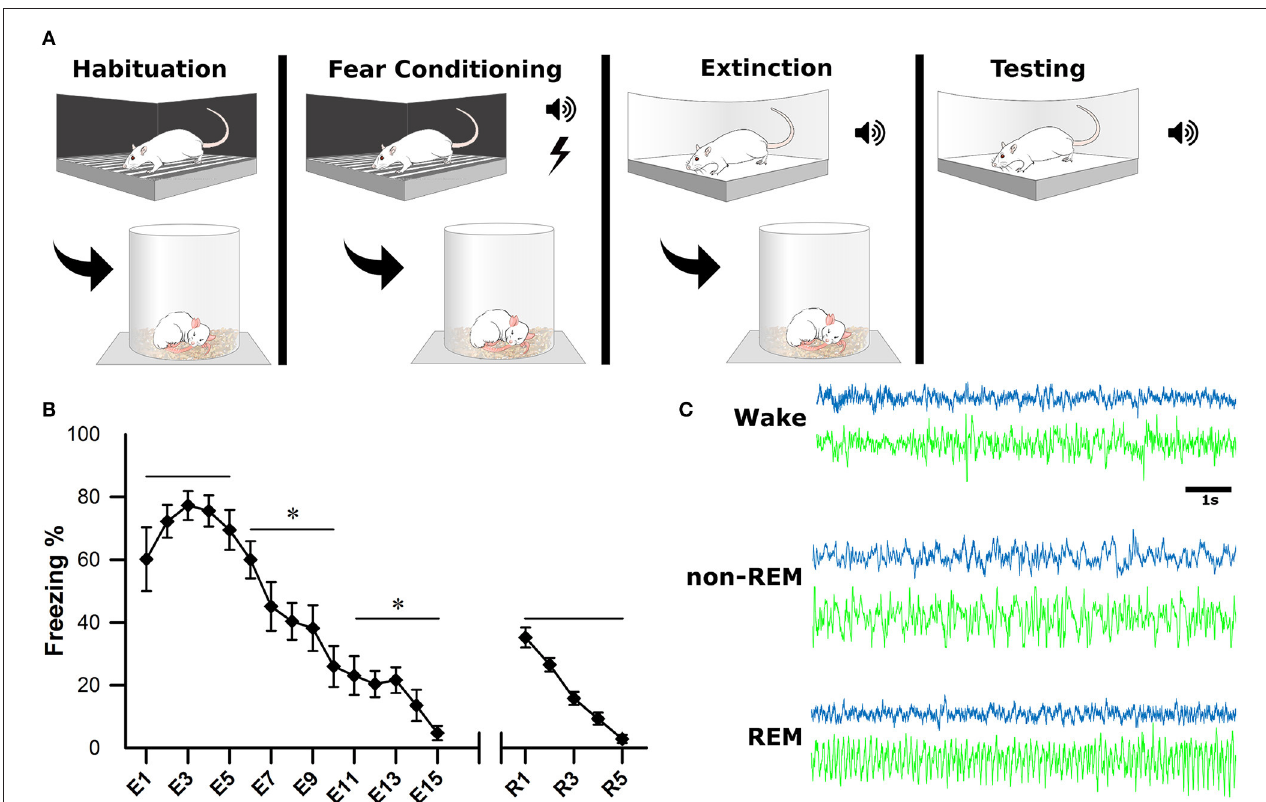
FIGURE 2 | Experimental Design. (A) One the first day, animals were habituated to the fear conditioning chamber for 15 min. On the second day, they were subjected to fear conditioning which consisted of three, 10-s tones followed by a 1-s footshock. On the third day, they were placed in a novel context for fear extinction. This consisted of replaying the conditioned tone 15 times (E1–E15), with 2-min inter-stimulus intervals. The final day, animals were tested for successful extinction of fear, which consisted of five more replays of the conditioned tone (R1–R5). Sleep-wake activity was recorded via EEG for 4 h following each of the first 3 experimental days. (B) Behavioral measurements of fear were calculated as a percentage of time spent freezing during tone replays. For statistical analysis, trials were grouped into pairs of five. *denotes that the below group of five trials was statistically different from the previous (left to right) p < 0.001. As a group, animals successfully acquired and extinguished cued fear memory. (C) Electrophysiological sleep-wake activity was later scored based on cortical (blue) and hippocampal (green)